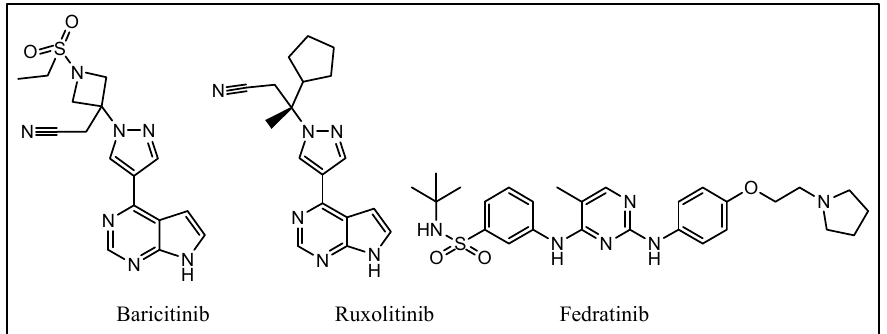
Figure 1. Some JAK inhibitors that are FDA approved and/or in clinical trials.